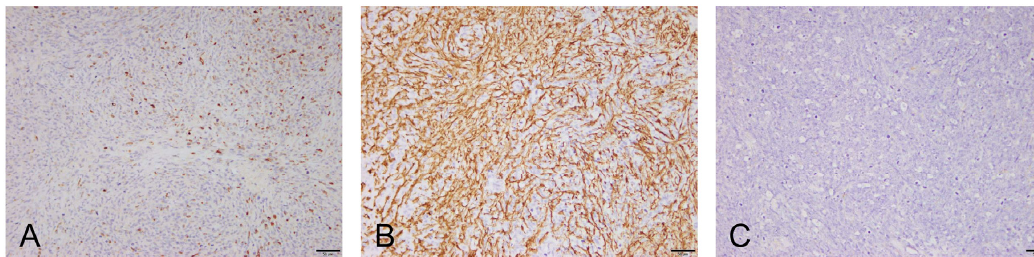
Figure 4. The figure depicts immunohistochemical staining of the tumor cells (counterstained with hematoxylin, 100×, scale bar = 50 μ m). The tumor cells were positive for desmin ( A ) and smooth muscle actin ( B ) and negative for S100 ( C ).